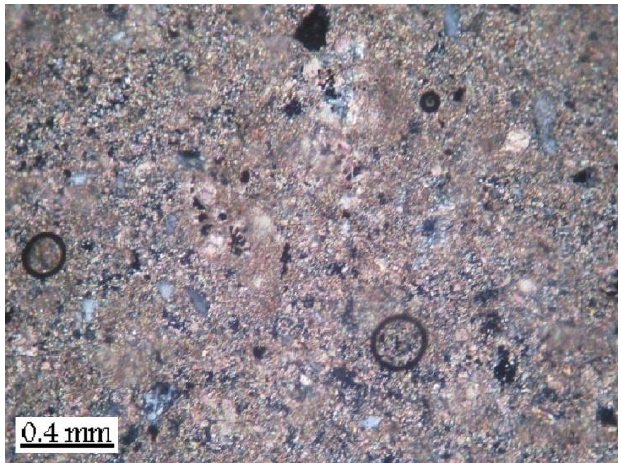
Figure 9. Anhydrite cement inside Madstone sediments